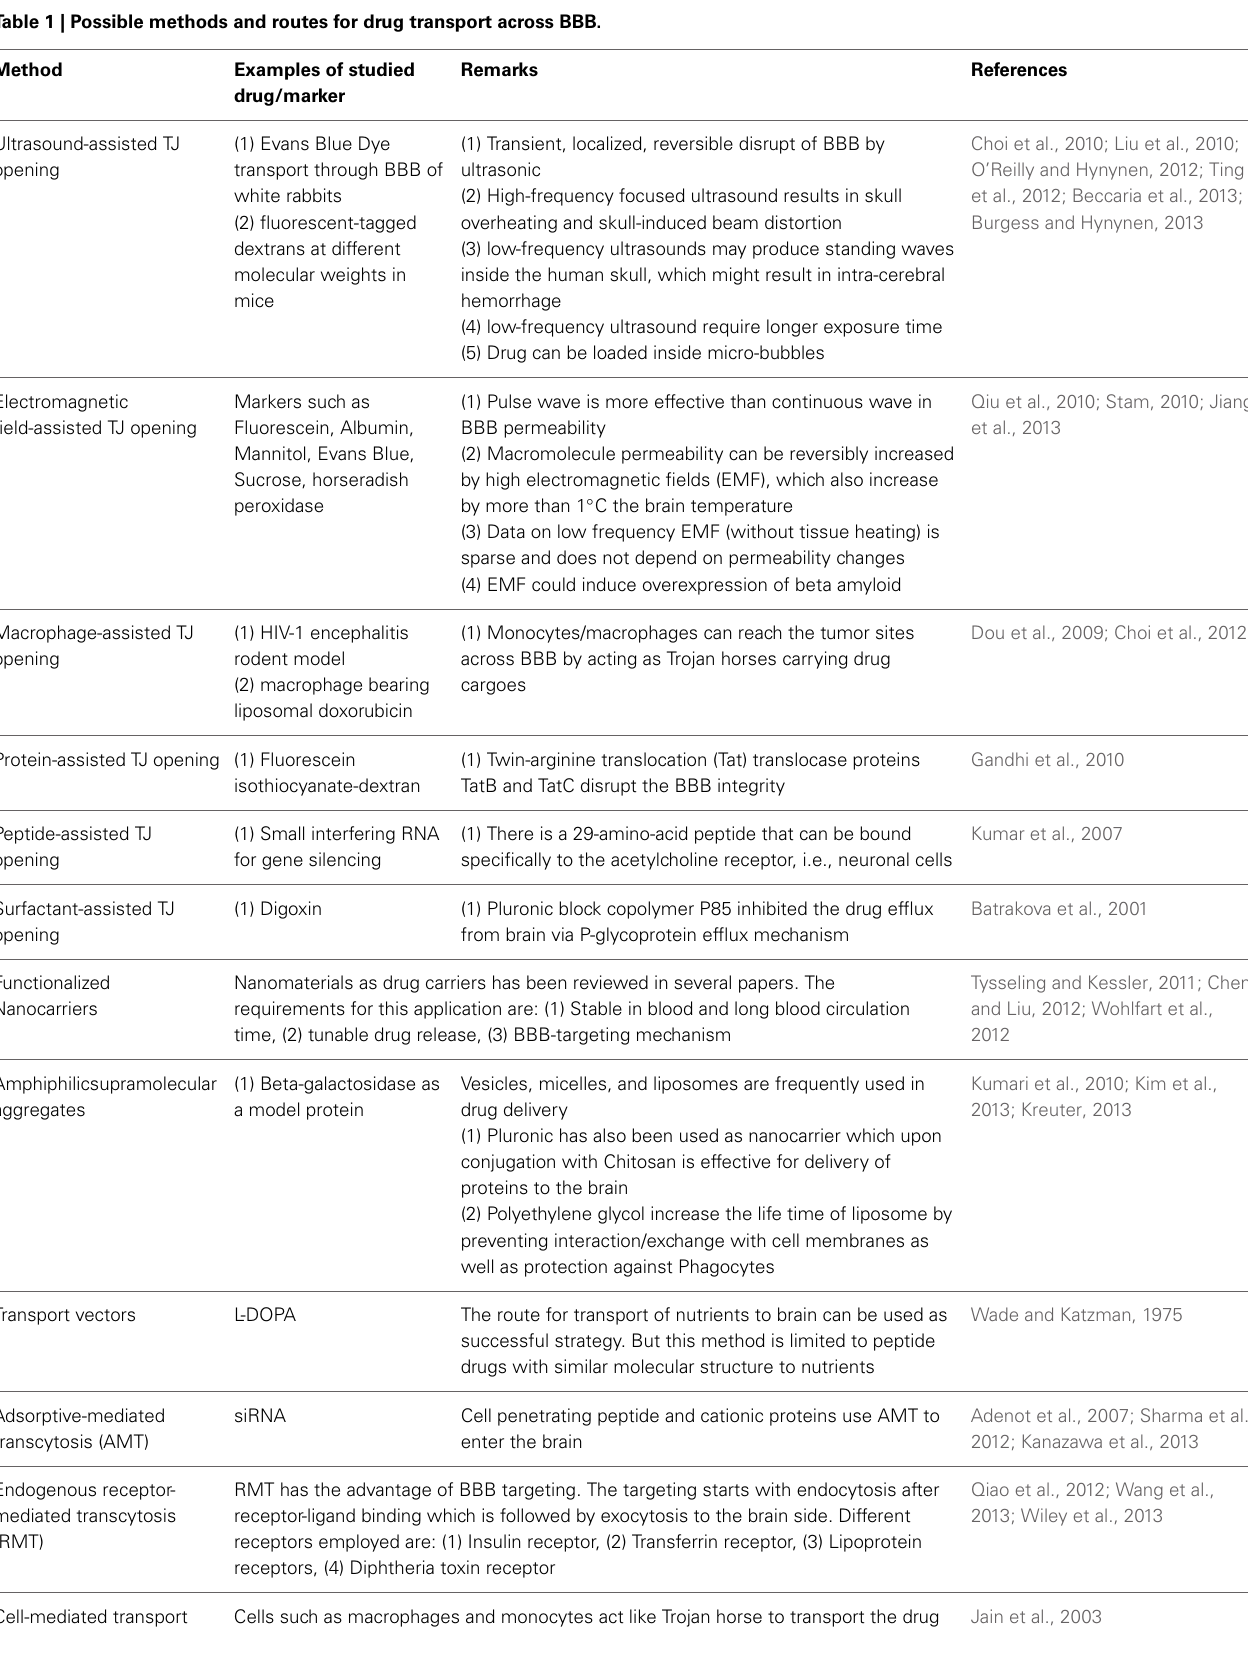
Table 1 | Possible methods and routes for drug transport across